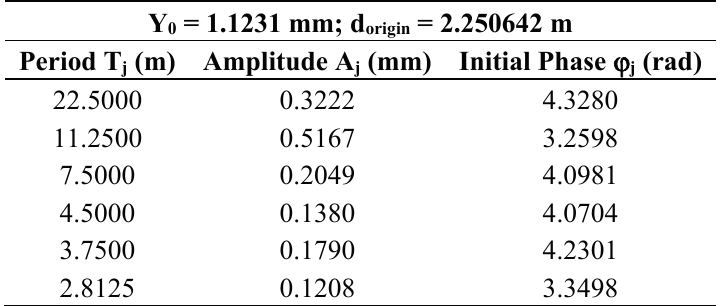
Table 12. Parameters of the correction function–Trimble